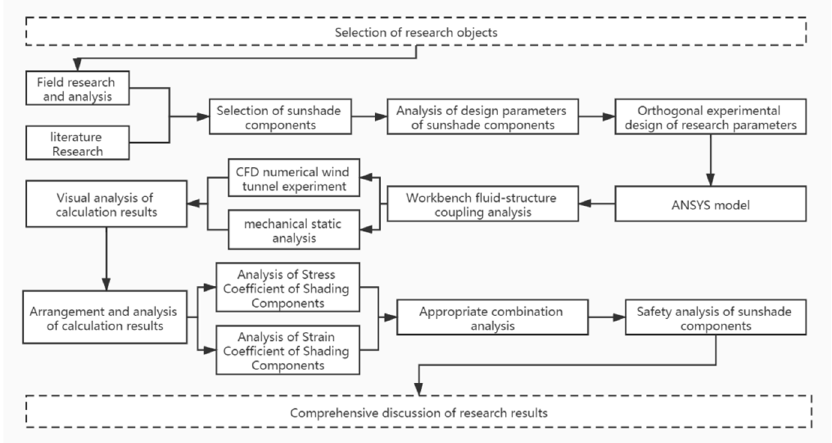
Figure 5. Road map of finite element analysis of structural forces.